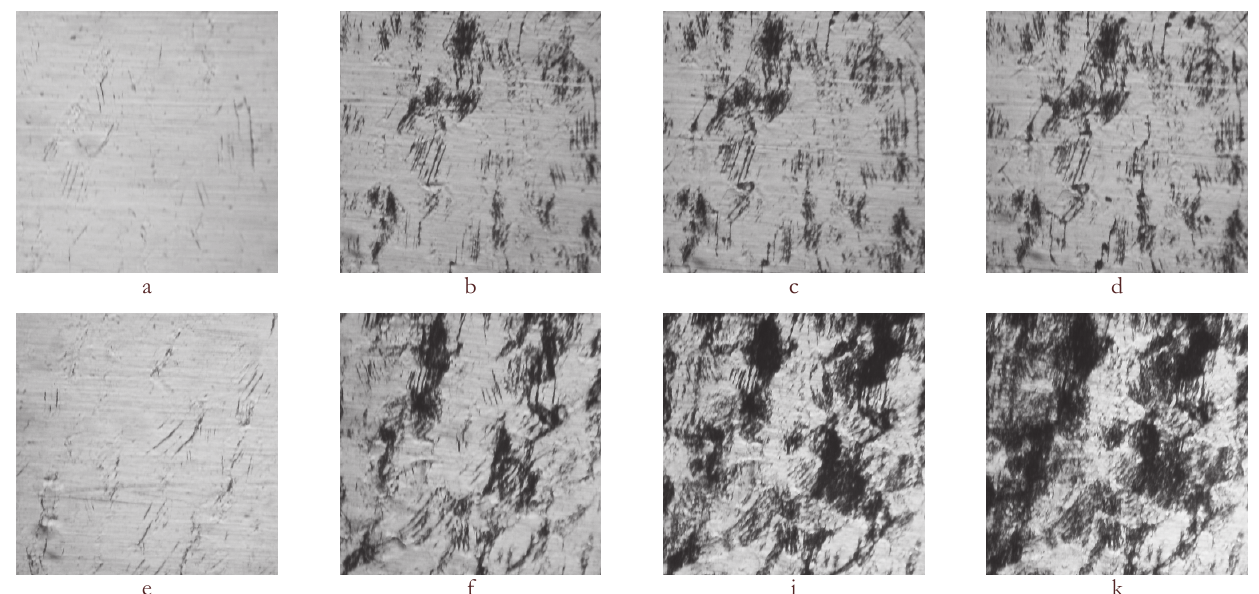
Figure 1: The surface images of strain induced relief found on the structure-sensitive fatigue gauge under bending (a-d) (N = 5000 cyles (a); 150000 (f); 100000 (i); 1000000 (k)), σ max =110 MPa and “bending + torsion” (e-k) loadings: (N = 5000 cyles (a); 25000 (f); 100000 (i); 512000